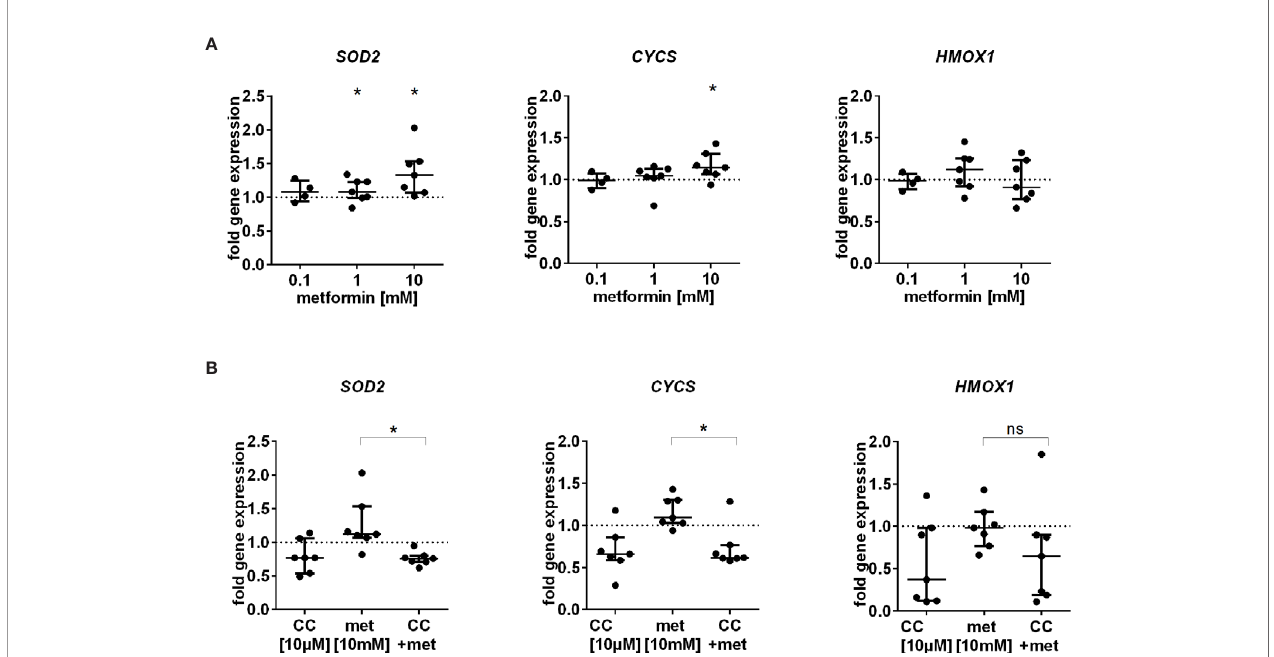
FIGURE 5 | Gene expression of antioxidative enzymes is induced by metformin. (A) RNA expression analysis of SOD2, CYCS and HMOX1 , three FOXO3 target genes after 3 h incubation with different dosages of metformin (n=4-7). (B) Antioxidative gene expression by metformin is AMPK dependent. Gene expression analysis of SOD2, CYCS and HMOX1 after 3 h incubation with metformin [10 mM] alone or in combination with CC [10 µM] (n=7). Gene expression was normalized to 18S rRNA and is depicted as fold induction to unstimulated control. Median with interquartile range is shown and signi fi cance was evaluated between unnormalized data and refers to unstimulated control using the Wilcoxon test. *P ≤ 0.05; ns, not signi fi cant.